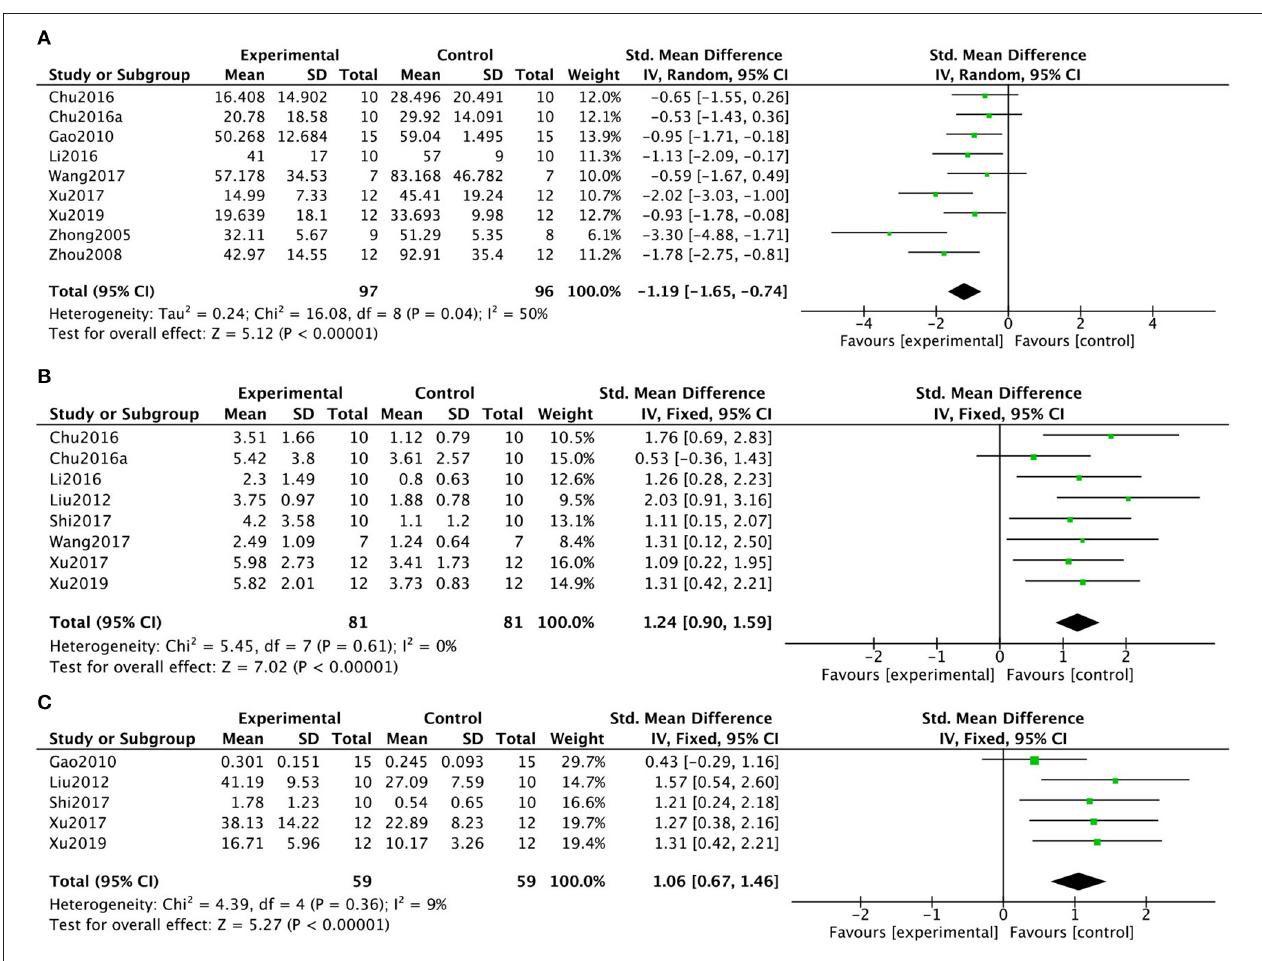
FIGURE 2 | Forest plot showing that KXS treatment decreased escape latency (A) , increased the number of target platform crossings (B) , and increased time spent on the target quadrants (C) in the Morris water maze test compared with the Control group.